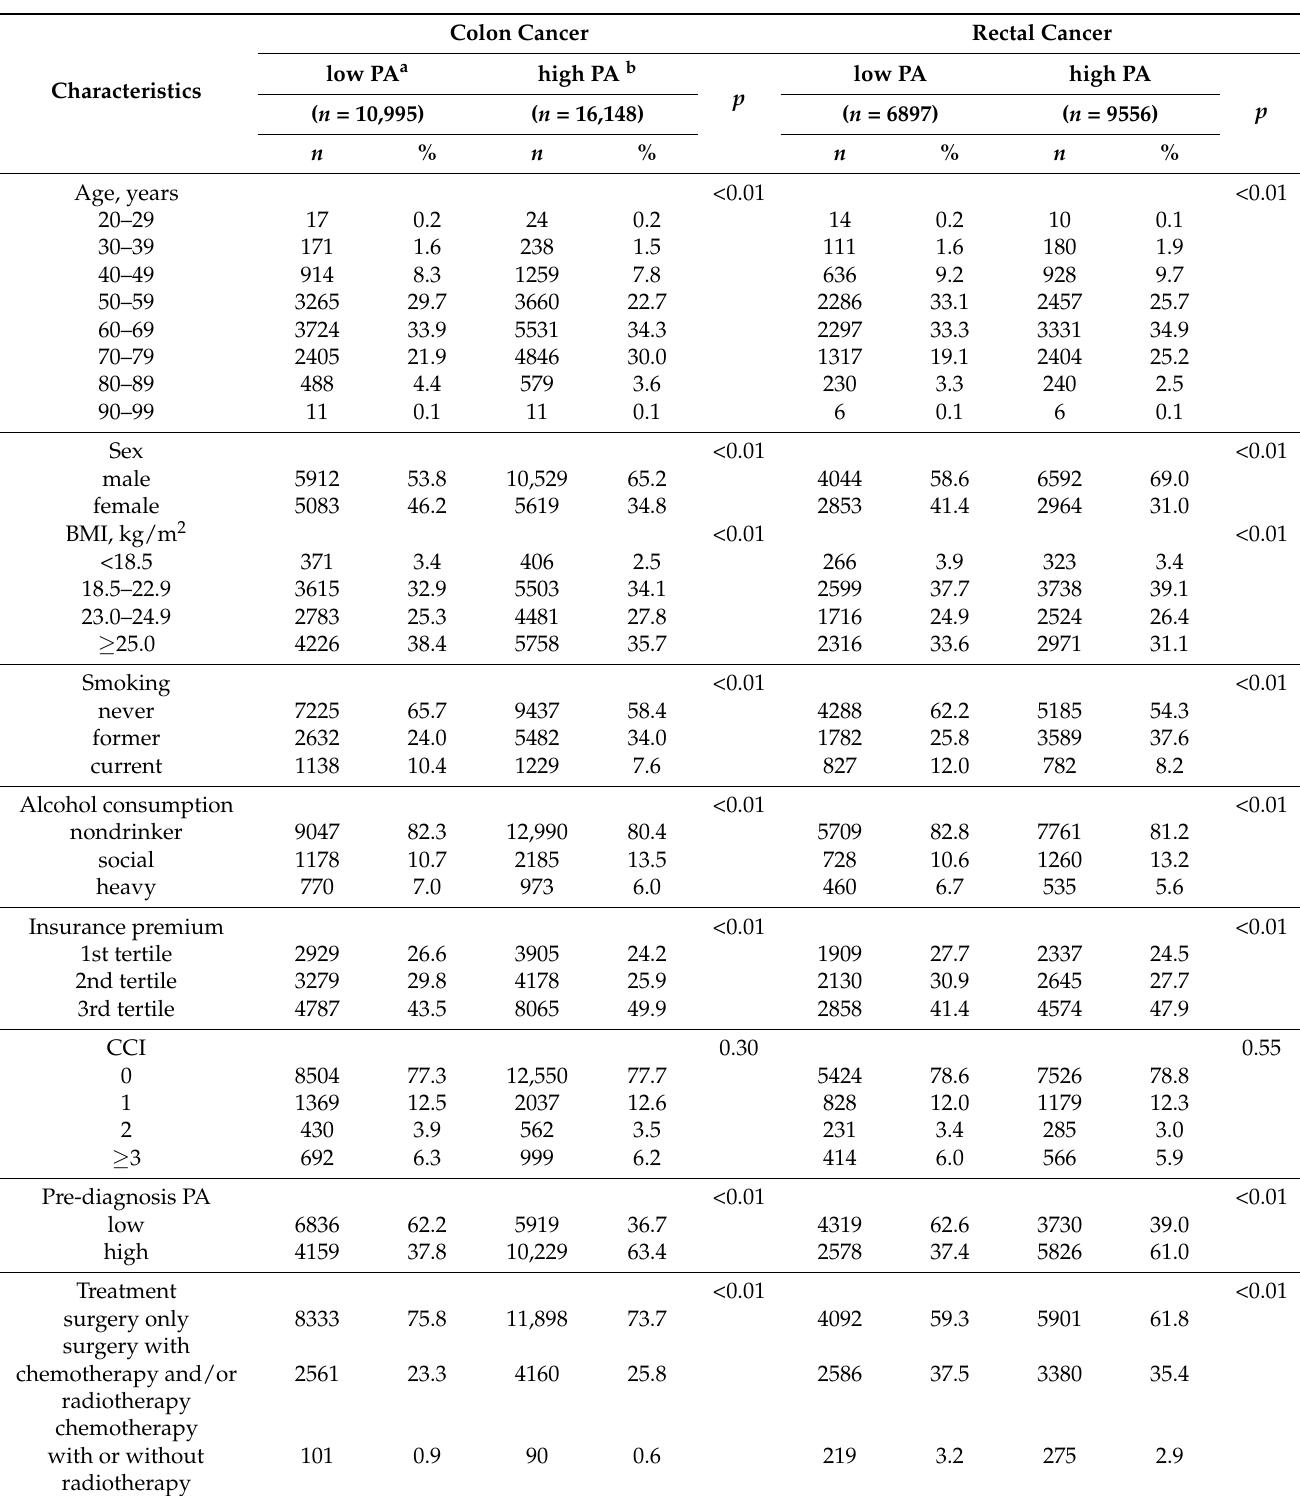
Table 2. Demographic and clinical characteristics of colorectal cancer patients by post-diagnosis physical activity levels,